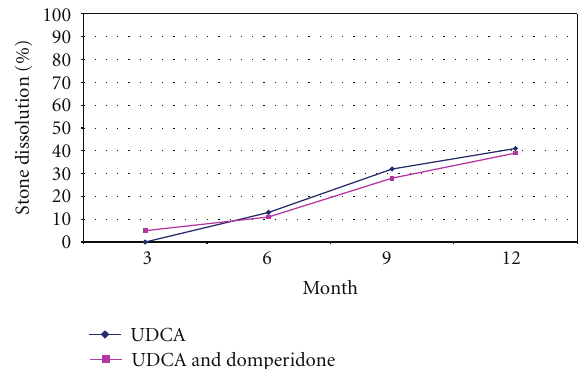
Figure 1: Stone dissolution rates with time in both treatment